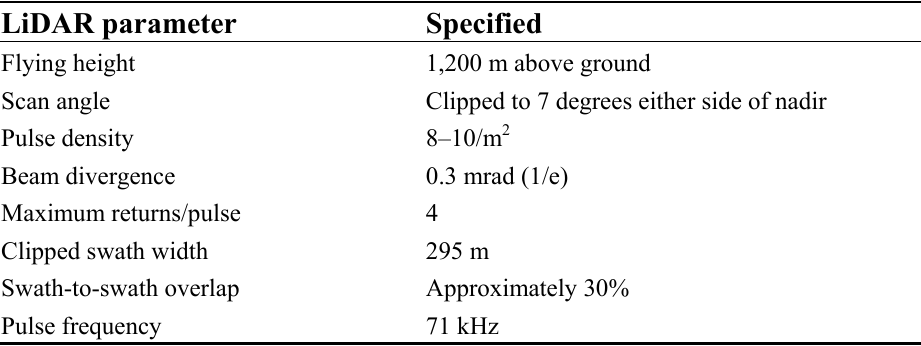
Table 1. Optech 3100EA LiDAR data acquisition